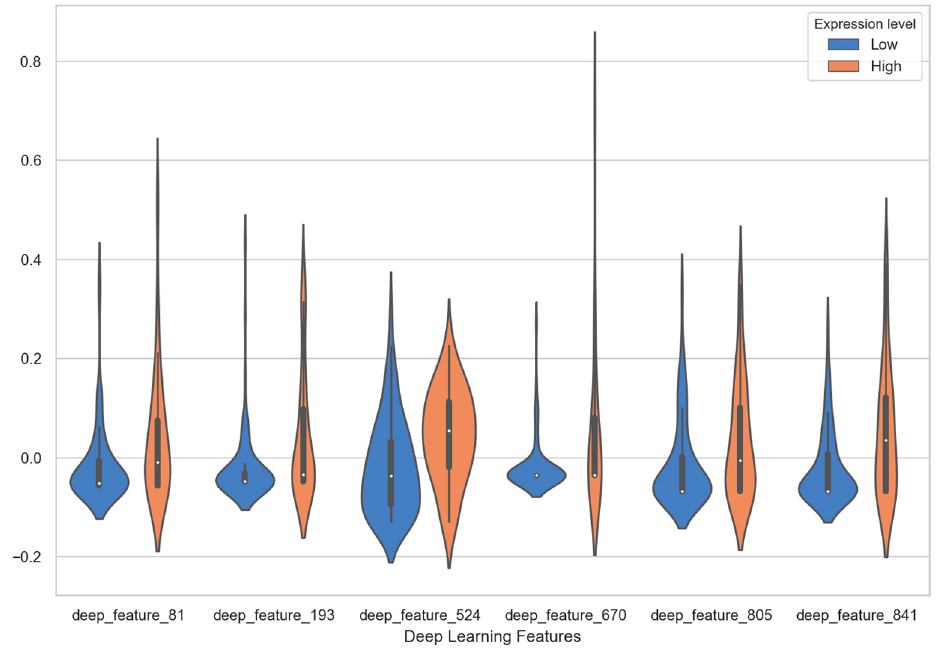
Figure 5. The violin plot of six deep learning features with high statistical significance distributions between the high PD-L1 expression level group and low expression level group.